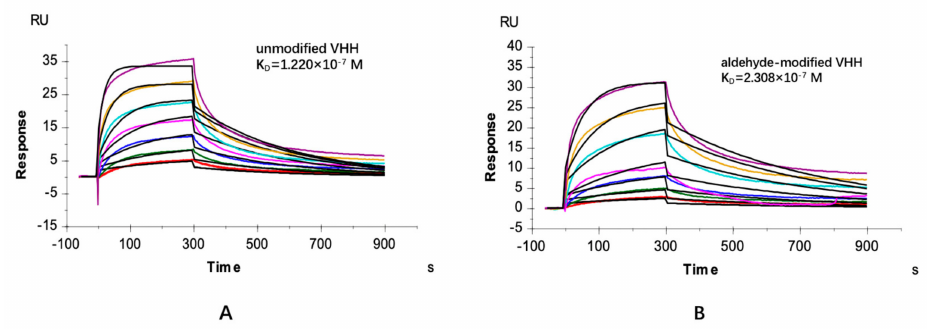
Figure 4. A ffi nities of the unmodified ( A ) and modified VHHs ( B ) binding β 2-m investigated by Biacore T200. For surface plasmon resonance spectroscopy (SPR)-based a ffi nity measurements, β 2-m was covalently coupled on a CM5-chip. Kinetic measurements were performed by injecting seven concentrations ((162.8, 81.40, 40.70, 20.35, 10.17, 5.087, 2.544) × 10 − 8 M) of purified VHHs. The obtained data sets were evaluated using the 1:1 Langmuir binding model.